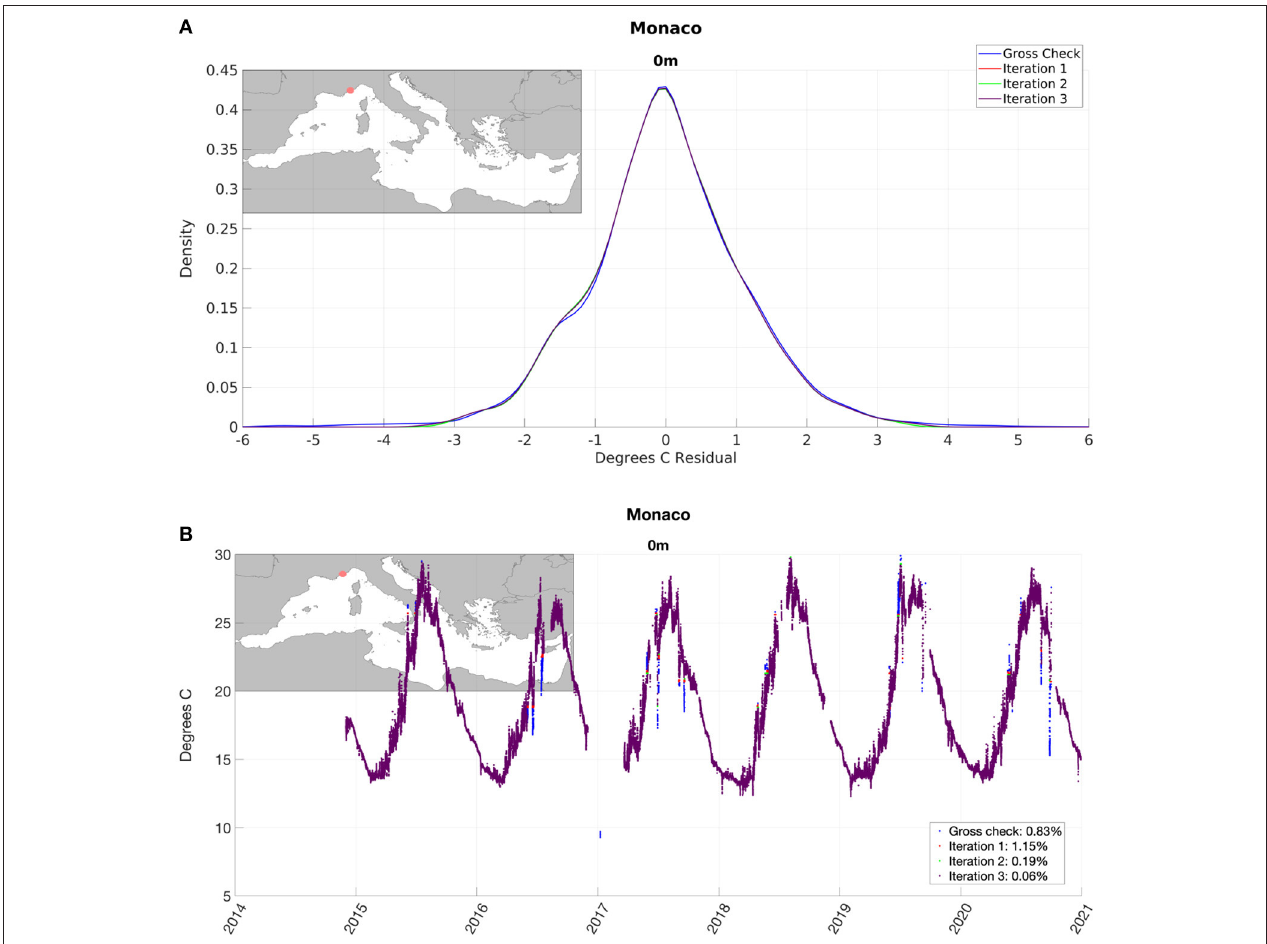
FIGURE 7 | Surface temperature at Monaco station: (A) Probability Density Function (PDF) computed from residuals; (B) statistical QC progression. The lines show the input data to the recursive statistical QC and the output of the 3 applied iterations.